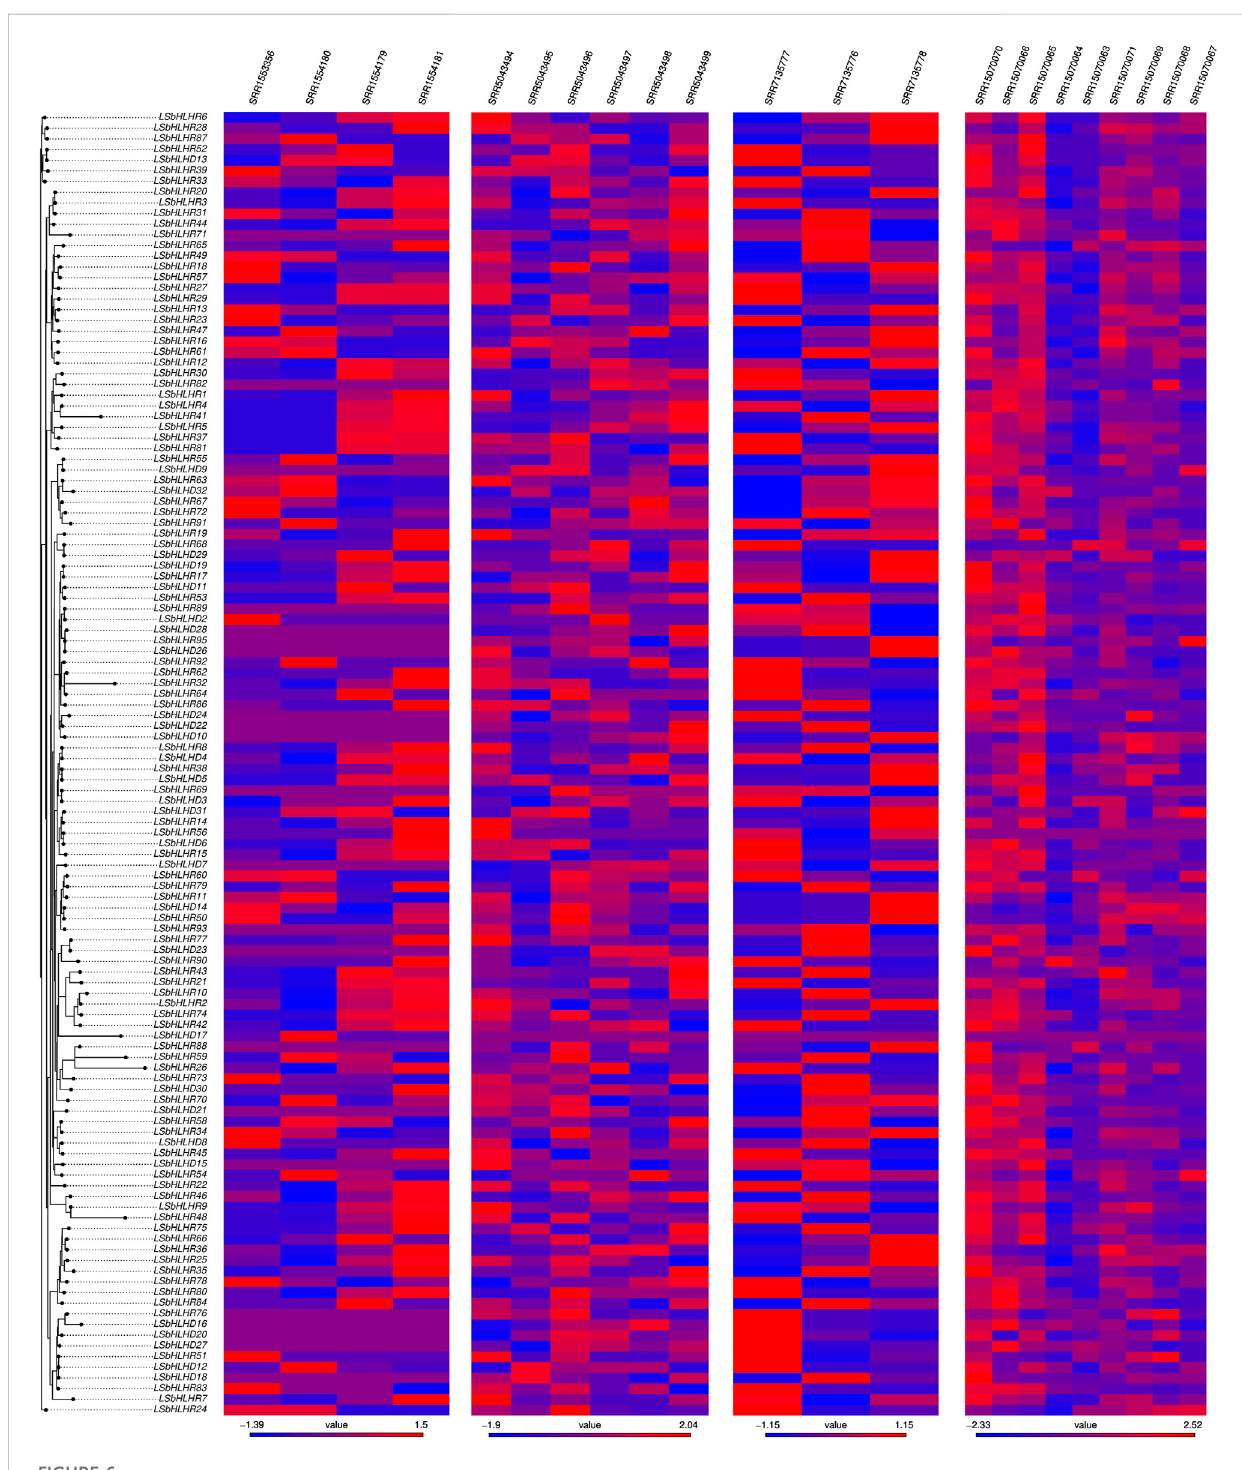
FIGURE 6 Heatmap represents the normalized count of mapped reads for the 122 identi fi ed LsbHLH genes, organized based on their phylogenetic relationships.Thedata wasderivedfromfour RNA-seq experiments conducted on grasspea underdifferentconditions, each containingmultiplerunsor samples. The accession number for each experiment is displayed above the corresponding plot. The color scale represents the level of gene expression, with red indicating high expression and blue indicating low